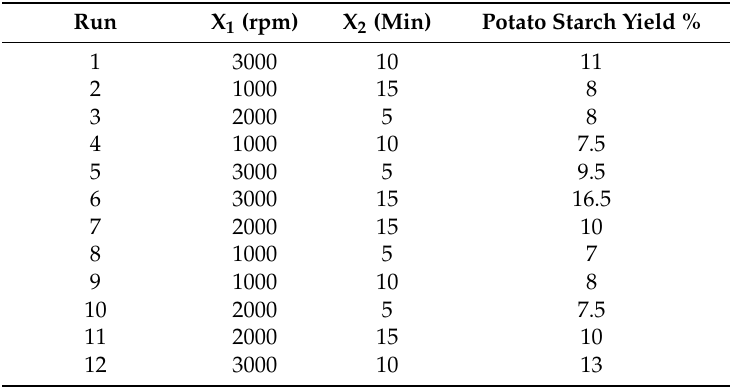
Table 2. The experimental values using central composite design.